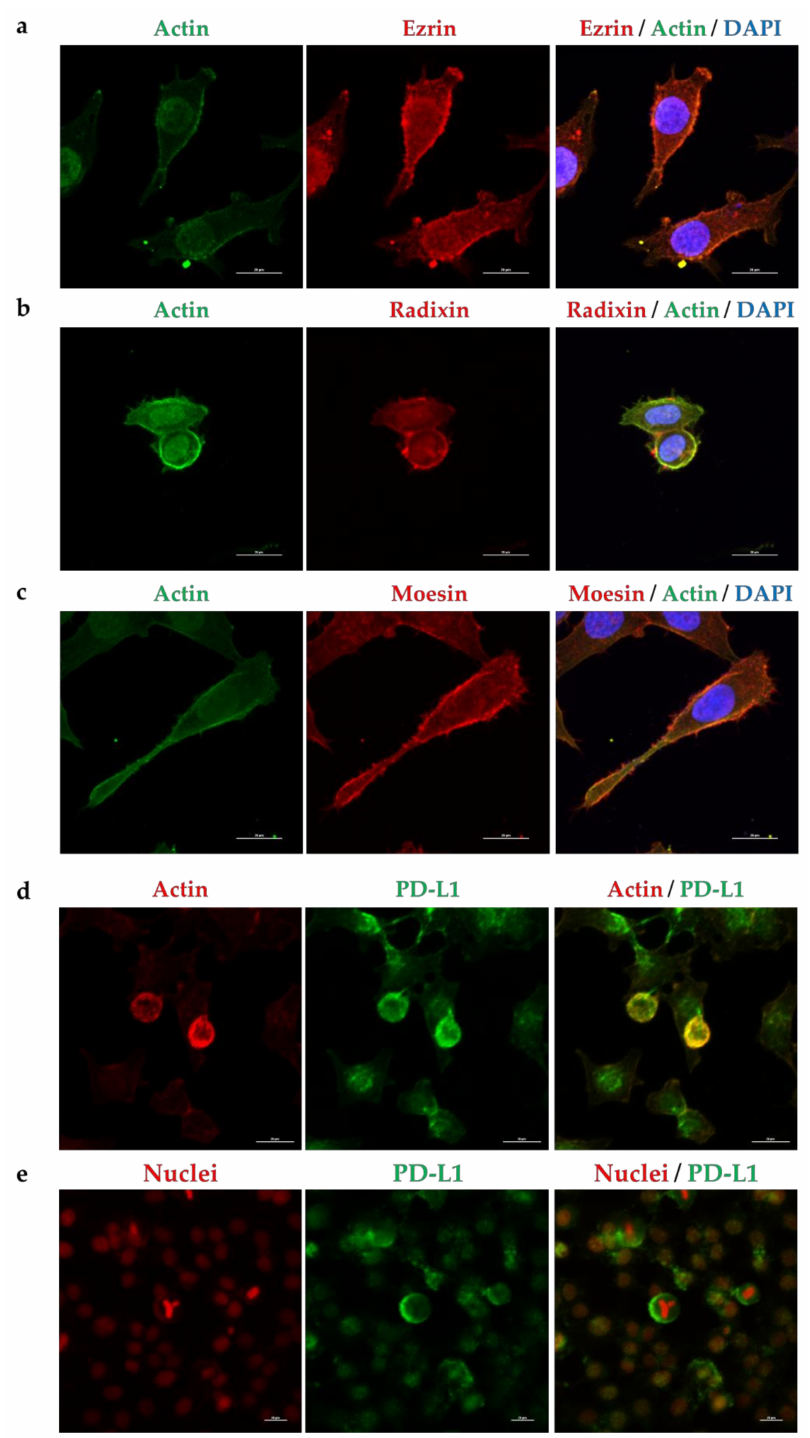
Figure 2. Subcellular localization of ezrin, radixin, moesin, and programmed cell death ligand-1 (PD-L1) in HeLa cells. Confocal laser scanning microscopy for subcellular localization ezrin, radixin, moesin, and PD-L1 in HeLa cells. In a three-dimensional reconstruction of optically sectioned HeLa cells, ( a ) ezrin, ( b ) radixin, and ( c ) moesin (red) were distributed near the plasma membrane and preferentially colocalized with actin (green), which was used as the plasma membrane maker. PD-L1 (green) was preferentially colocalized with ( d ) actin (red) on the plasma membrane, but not with ( e ) nuclei (red). Scale bars: 20 µ m. All data are representative of at least three independent